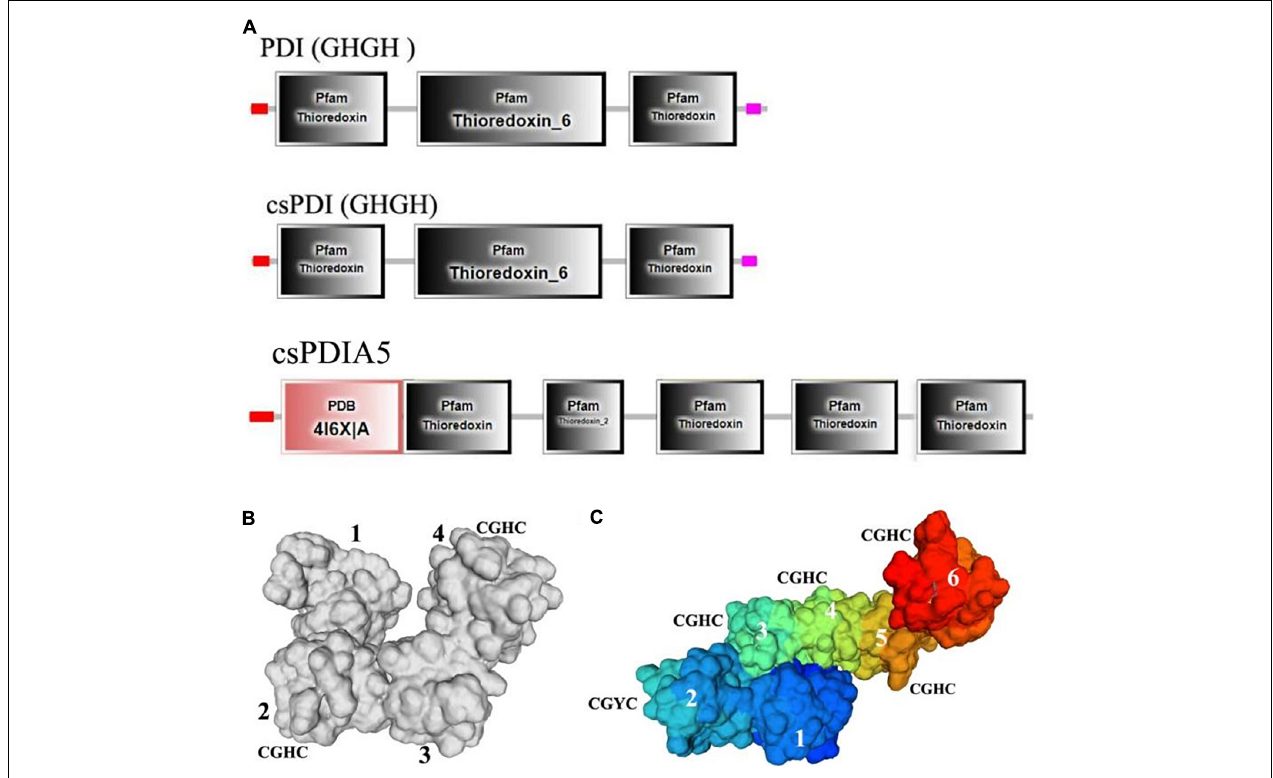
FIGURE 7 | Comparisons of the secondary and tertiary domains among csPDIA5, PDI GHGH, and csPDI GHGH from C. textile . (A) , Comparisons of the tertiary structures of csPDIA5, PDI GHGH, and csPDI GHGH. (B) , The tertiary structure of csPDIA5; (C) , The tertiary structure of csPDI